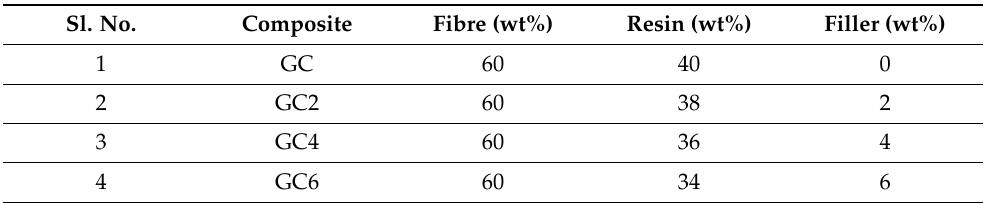
Table 1. Detail of the fabricated specimens.